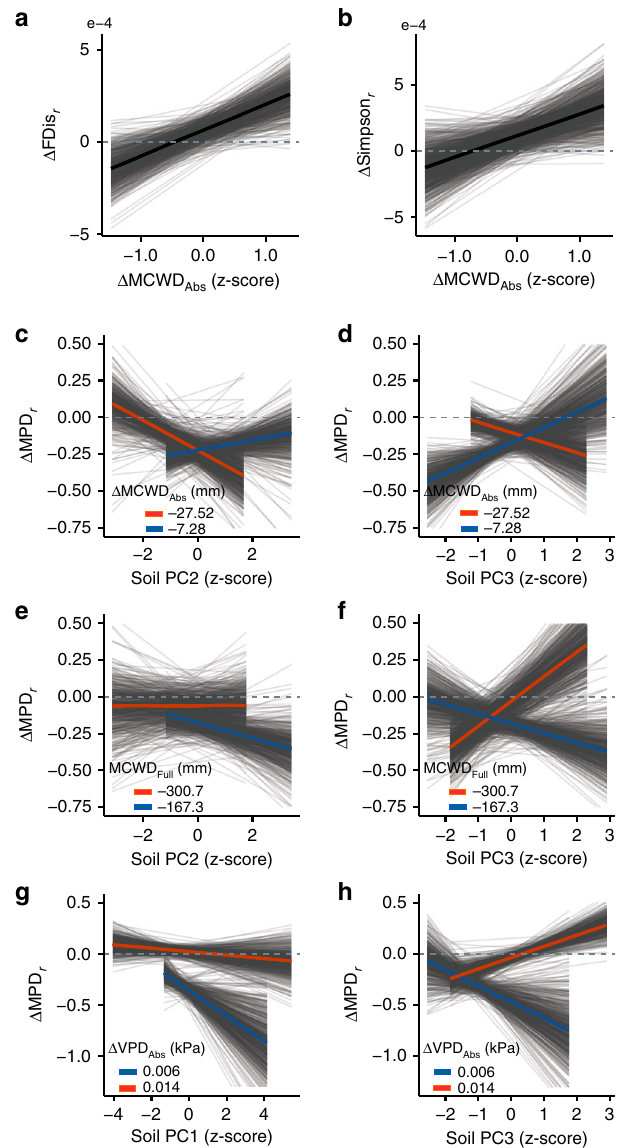
Fig. 3 Climatic and soil drivers of observed rates of change in the three facets of diversity. a Functional ( Δ FDis r ), b taxonomic ( Δ Simpson r ) and c – h phylogenetic ( Δ MPD r ) diversity in West African forest communities. Changes in functional and taxonomic diversity were mainly explained by the absolute changes in the maximum climatic water de fi cit ( Δ MCWD Abs ). Observed changes in phylogenetic diversity were better explained by the soil characteristics covered by the three PC axes (Supplementary Table 3) and their interaction with climatic drivers ( Δ MCWD Abs , Δ MCWD Full , Δ VPD Abs ). PC1: eCEC( + ), magnesium( + ) and nitrogen( + ); PC2: pH( − ), Fe( + ) and Ca ( − ); PC3: %Clay( − ) and %Sand( + ). The solid black fi tted line shows the mean posterior prediction for the functional and taxonym diversity change models. The red and blue fi tted lines shows the mean posterior predictions for the phylogenetic diversity based on the minimum and maximum values of the climatic drivers included in the model (Table 1). Grey lines show 700 random draws from the posterior distribution representing variability of the expected model fi t. n = 21 unique vegetation